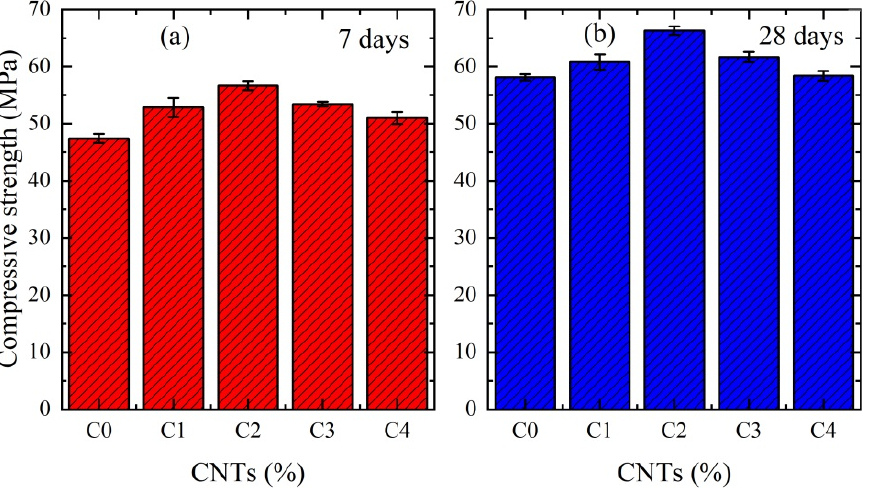
Figure 5. Compressive strength of cement mortars with different wt.% of MWCNTs. The results are for 40 min of ultrasonication time with surfactant. ( a ) for 7 days ( b ) for 28 days.